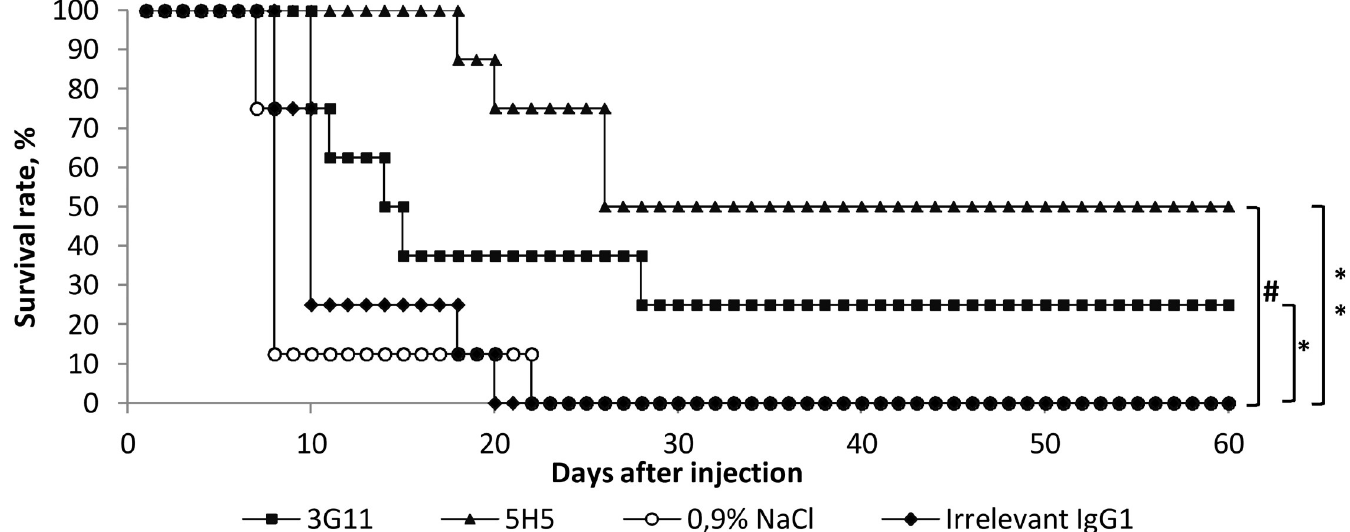
Fig 8. Protection of mice by mAbs 3G11 and 5H5 against fungal infection. BALB/c mice were administered (i.p.) once the indicated mAbs (150 μ g/mouse in 0.5 mL 0.9% NaCl) or 0.5 mL 0.9% NaCl, and 2 h later, the mice received a lethal dose of C . albicans (5 × 10 6 CFU/mouse). The survival rate of mice treated with mAb 5H5 was significantly higher than that of mice injected with 0.9% NaCl or an irrelevant mAb; #p < 0.05. The survival time of mice passively immunized with mAb 3G11 or mAb 5H5 was significantly higher than that of mice administered with 0.9% NaCl or an irrelevant mAb; � p < 0.01, �� p < 0.001.